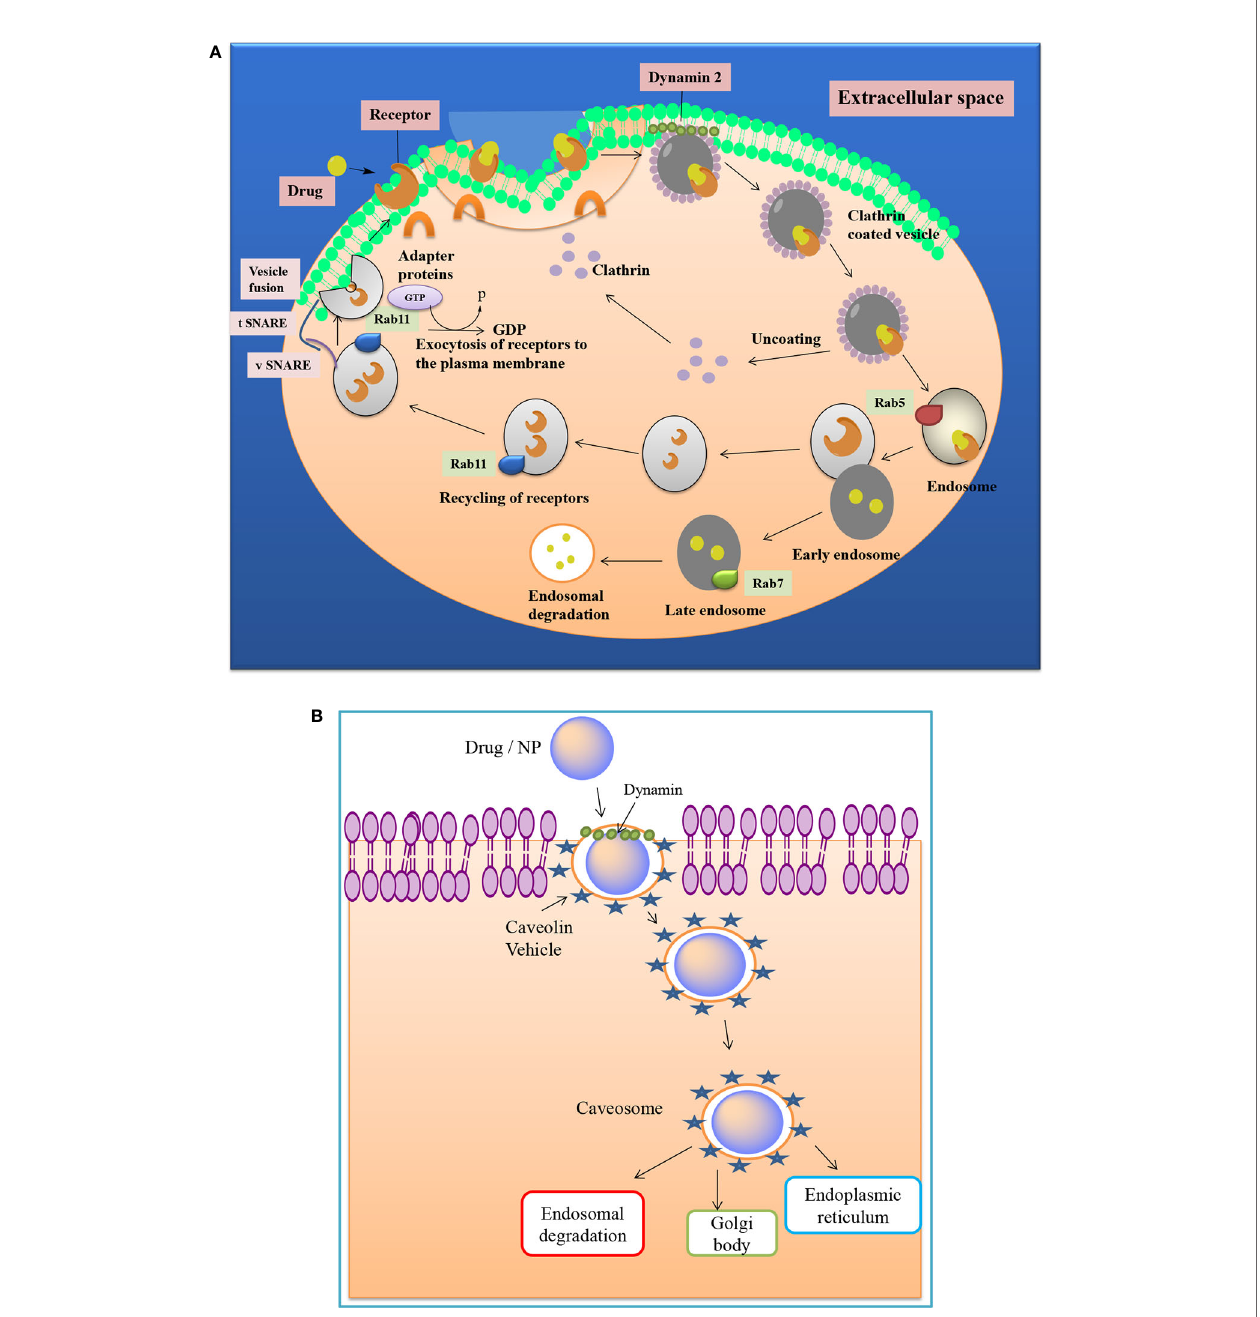
FIGURE 2 | (A) Clathrin mediated drug transport across the cell membrane. Cell surface receptors bind the exogenous ligand and internalize the moiety by formation of clathrin, which implicates the role of various proteins like Rab, GTPases, and SNARE proteins etc. (B) Caveolae mediated transport of a drug or nanoparticle. It involves the formation of bulb-shaped, 50-60 nm plasma membrane invaginations, called caveolae, whose formation is driven by integral membrane proteins and peripheral membrane